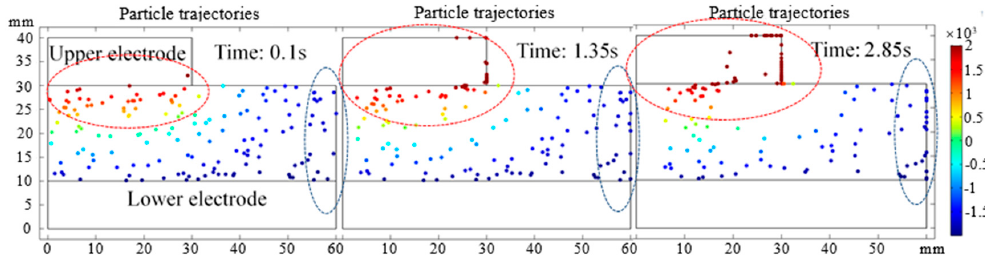
Figure 6. The simulation of movement of SiO 2 abrasive under both DEP force and centrifugal force.